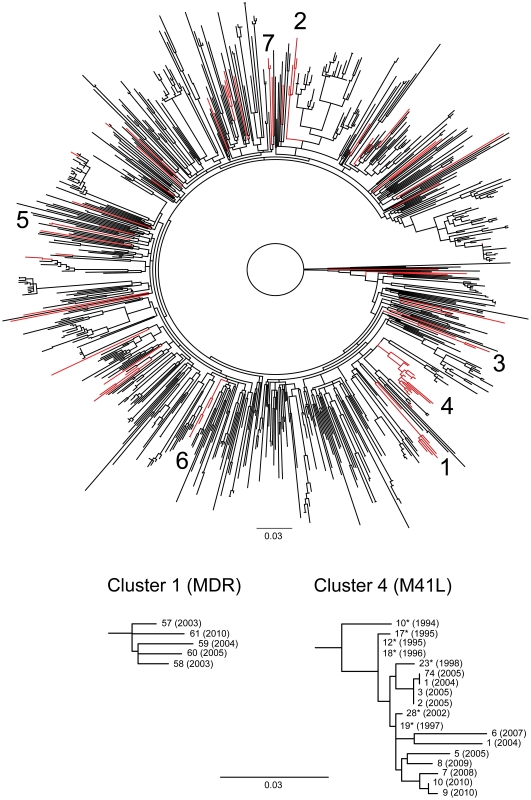
Maximum likelihood phylogenetic analysis of study subjects infected with HIV-1 of subtype B.The upper panel shows the complete tree, which includes sequences from 605 study subjects, 194 MSM diagnosed as HIV-1 infected in Stockholm 1992–2002 [17], and four subtype B and four subtype D reference sequences (www.hiv.lanl.gov). The tree was generated using partial HIV-1 pol gene sequences using PhyML and the best fitted nucleotide substitution model (i.e. GTR+I+G). Twenty-three codons with resistance mutations were removed from the alignment so that the final alignment contained 987 unambiguously aligned nucleotides. The tree is rooted using the four subtype D reference sequences. Red branches represent sequences with mutations indicative of TDR according to the WHO 2009 list of mutations for surveillance of transmitted drug resistance [20]. Numbers indicate significantly supported (aLRT>0.95) clusters of TDR sequences. The two bottom panels show detailed sub-trees for TDR clusters 1 and 4. The asterisks in the sequence identifiers in cluster 4 indicate that these sequences were obtained from the 1992–2002 dataset [17]. The scale indicates nucleotide substitutions per site.